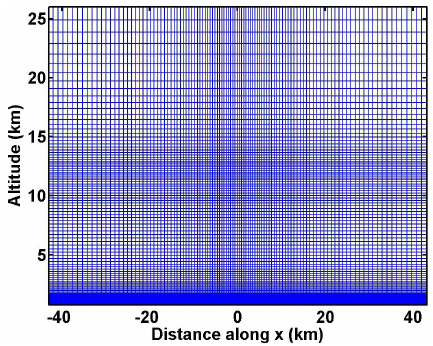
Figure 3. The 110×100 grid points in the computational